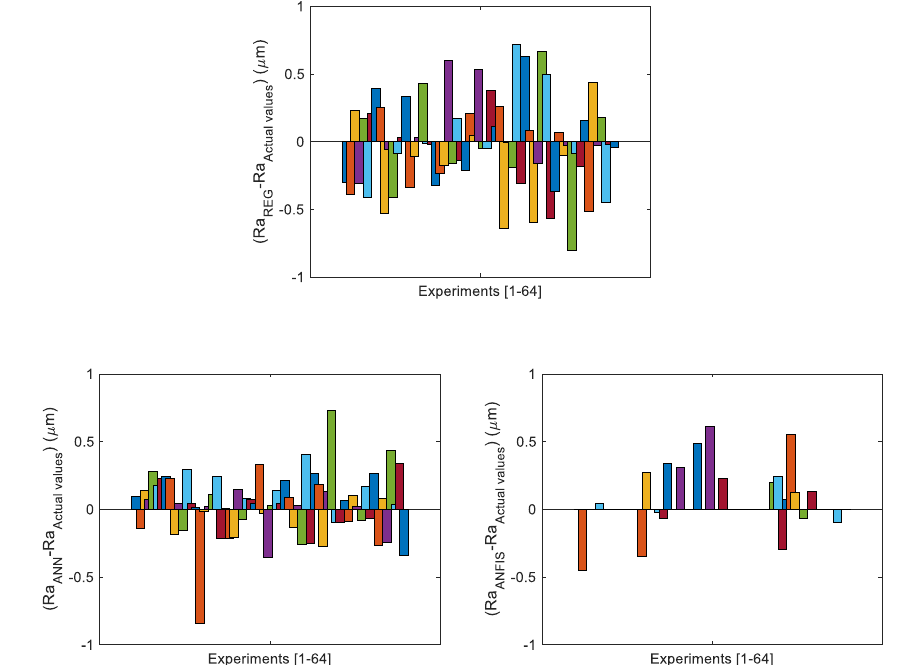
Figure 32. Difference between the actual values and those provided by the (Regression, ANN 3-8-1 and ANFIS) models for modeling Ra (μm) (Type 1 function). The data for obtaining these graphs have been taken from Ref. [61]).